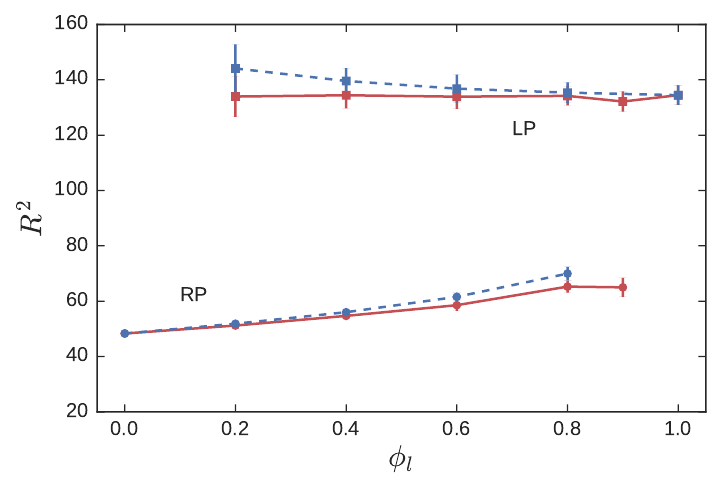
Figure 2. The squared radius of gyration of RPs (circles) and LPs (squares) in a symmetric blend with N l = N r = 300, as a function of the linear fraction. Solid red lines represent NC simulations, while blue dashed lines represent CX